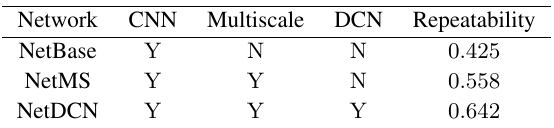
Figure 4. Example of keypoint feature maps generated from different weight combinations. (a) is the original remote sensing image. (b), (c), (d), (e) are keypoint feature maps result with weight combinations C 3 , C 4 , C 7 , C 9 , respectively. Table 1. Evaluation result of repeatability performance by different network